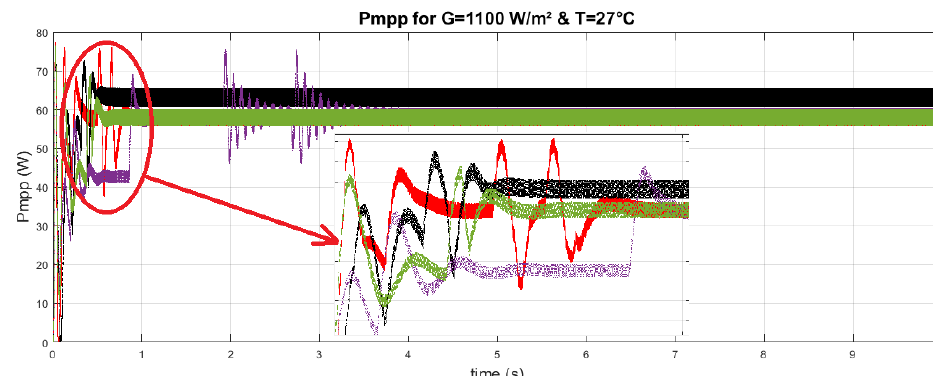
Figure 17. P pv at 3:00 p.m., third time of the day.